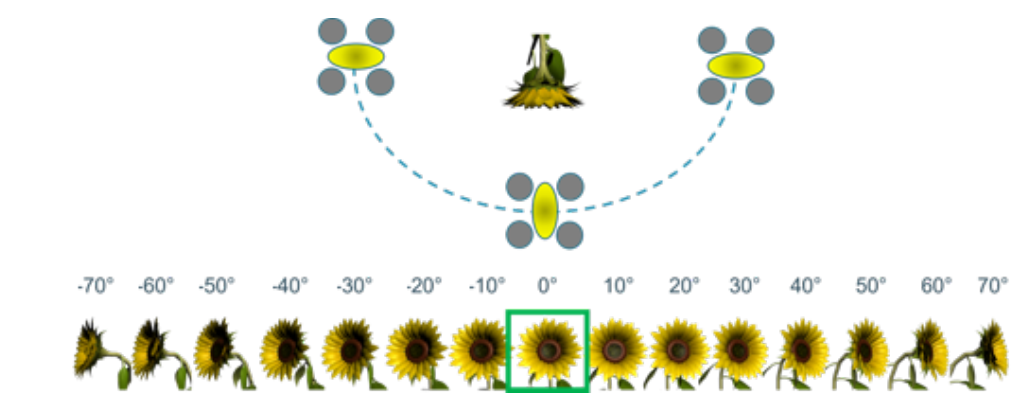
Figure 12. Illustration on the horizontal angle detection of the flower.